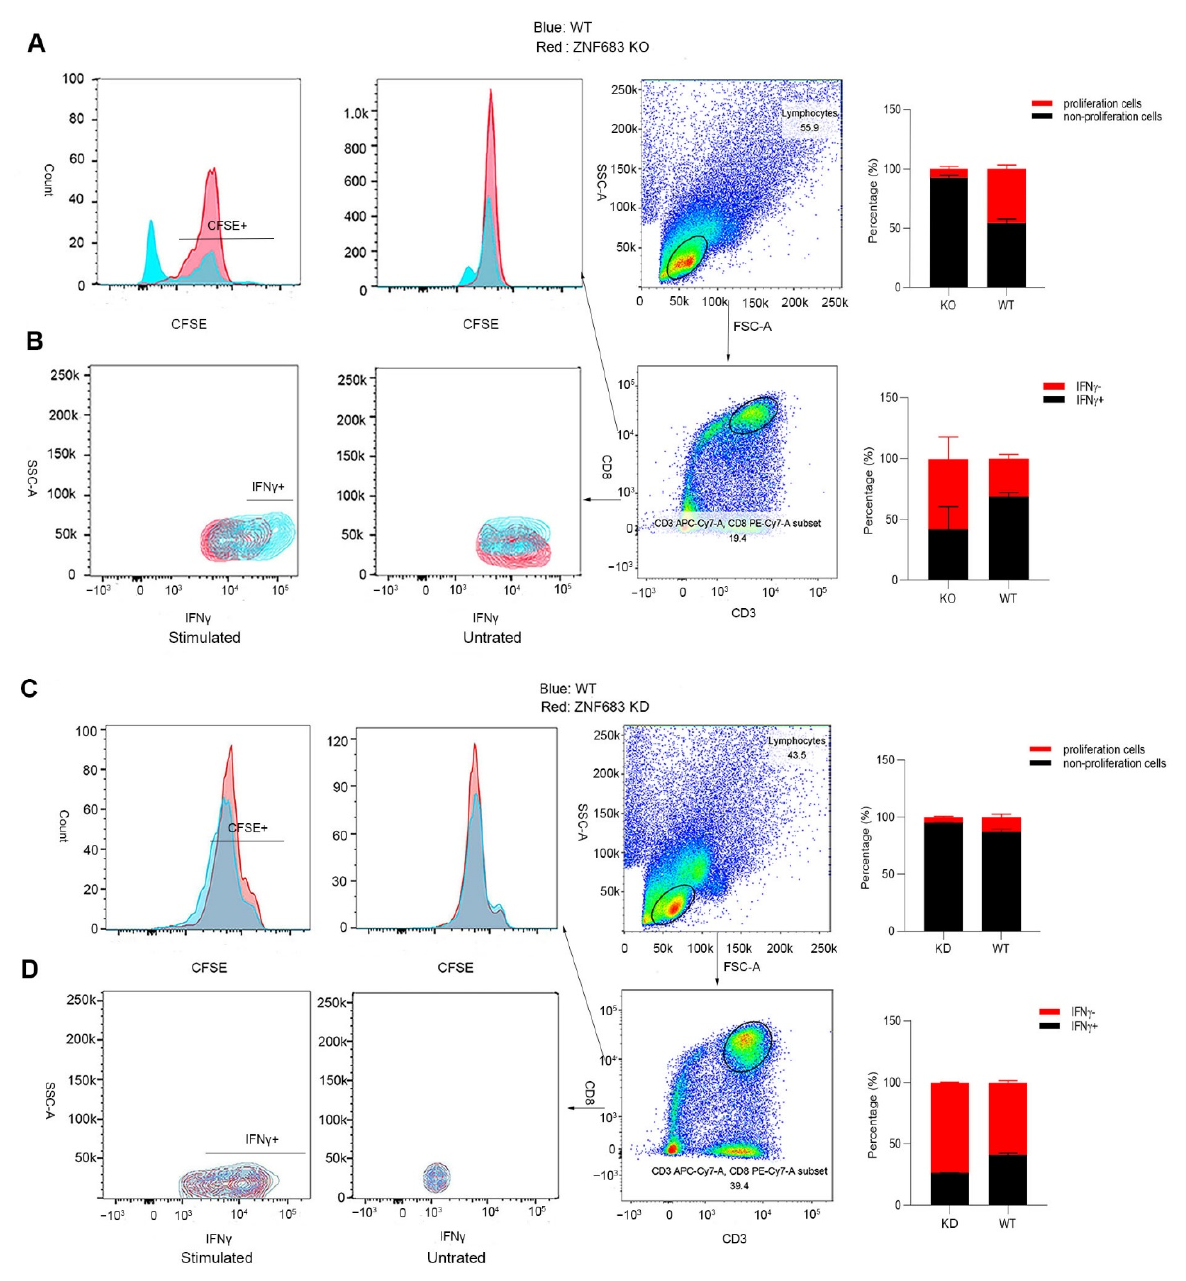
Figure 5. Analysis of the role of ZNF683 in CD8+ T cells in NPMs and humans. ( A ) ZNF683 increased the proliferation of CD8+ T cells in NPMs. ( B ) ZNF683 promoted the production of IFN γ of CD8+ T cells in NPMs. ( C ) ZNF683 increased the proliferation of CD8+ T cells in humans. ( D ) ZNF683 promoted the production of IFN γ of CD8+ T cells in humans. Each experiment was repeated two times, and representative figures were selected randomly.